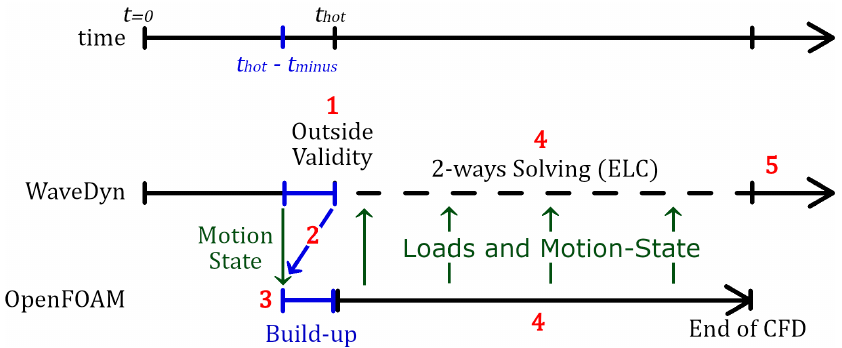
Figure 2. Time-splitting strategy as function of